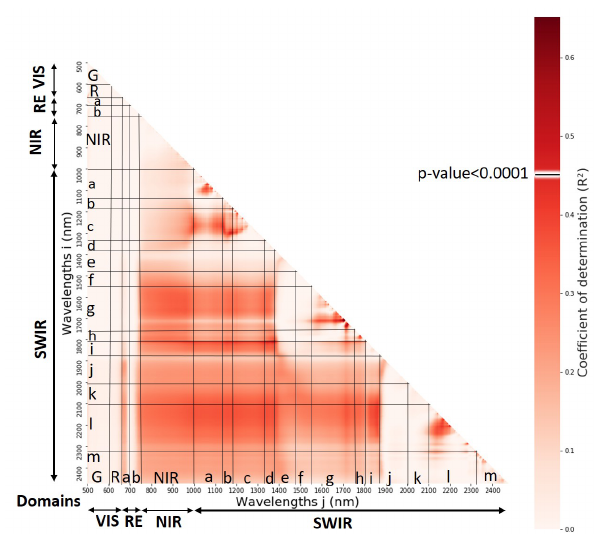
Figure 16. Correlation matrix showing the coefficient of determination between NDSI’s results and SWP when considering the whole database. The spectral domains defined in Table 6 are also reported along the two